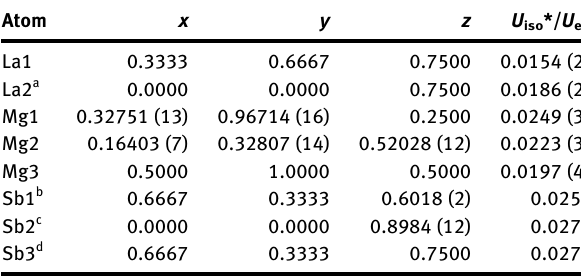
Table  : Fractional atomic coordinates and isotropic or equivalent isotropic displacement parameters (Å 